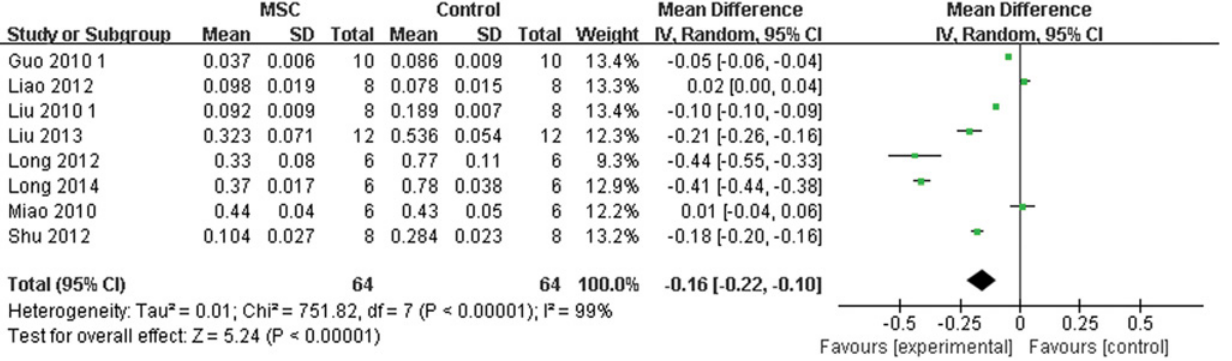
Fig 4. Forest plot showing the impact of mesenchymal stem cell (MSC) therapy on neointimal area, compared with controls. Abbreviations: SD = standard deviation, IV = independent variable, 95% CI = 95% confidence interval.